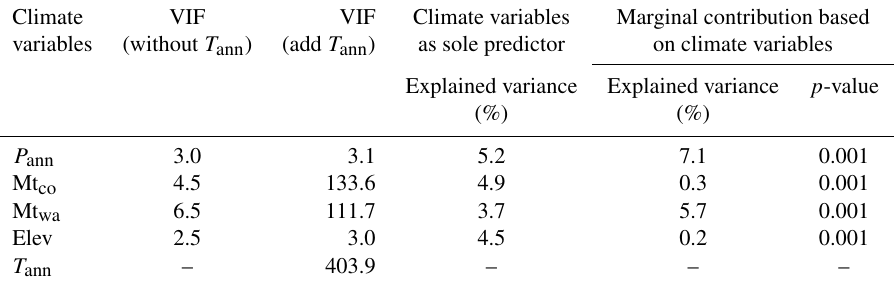
Table 1. Summary statistics for redundancy analysis (RDA) with 19 pollen taxa and 4 climate variables. VIF: variance inflation factor; P ann : mean annual precipitation (mm); Mt co : mean temperature of the coldest month ( ◦ C); Mt wa : mean temperature of the warmest month ( ◦ C); T ann : mean annual temperature ( ◦ C); and Elev: elevation (ma.s.l).